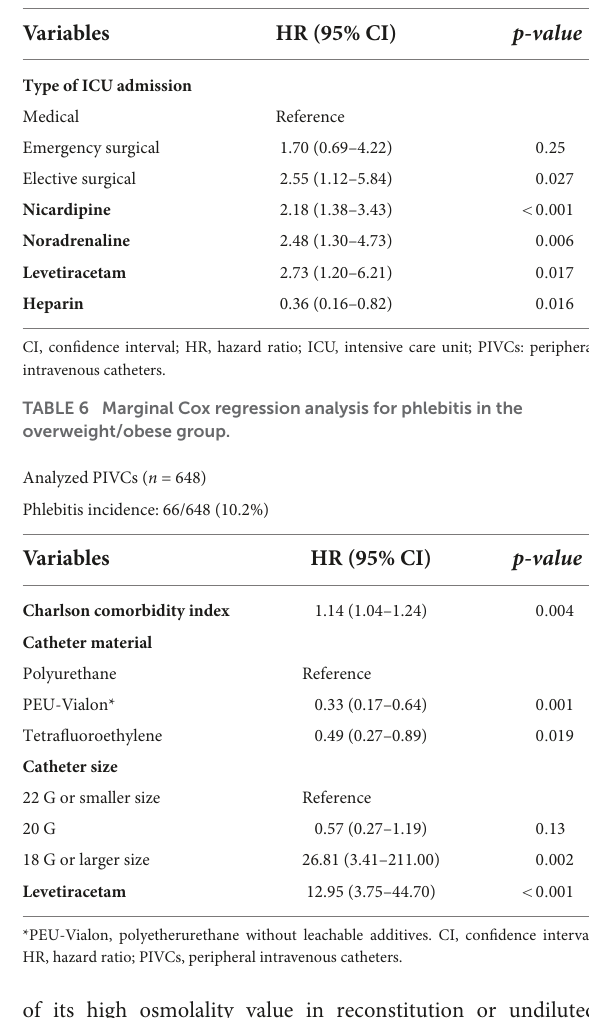
presentation (26). We may need to be cautious about how levetiracetam is